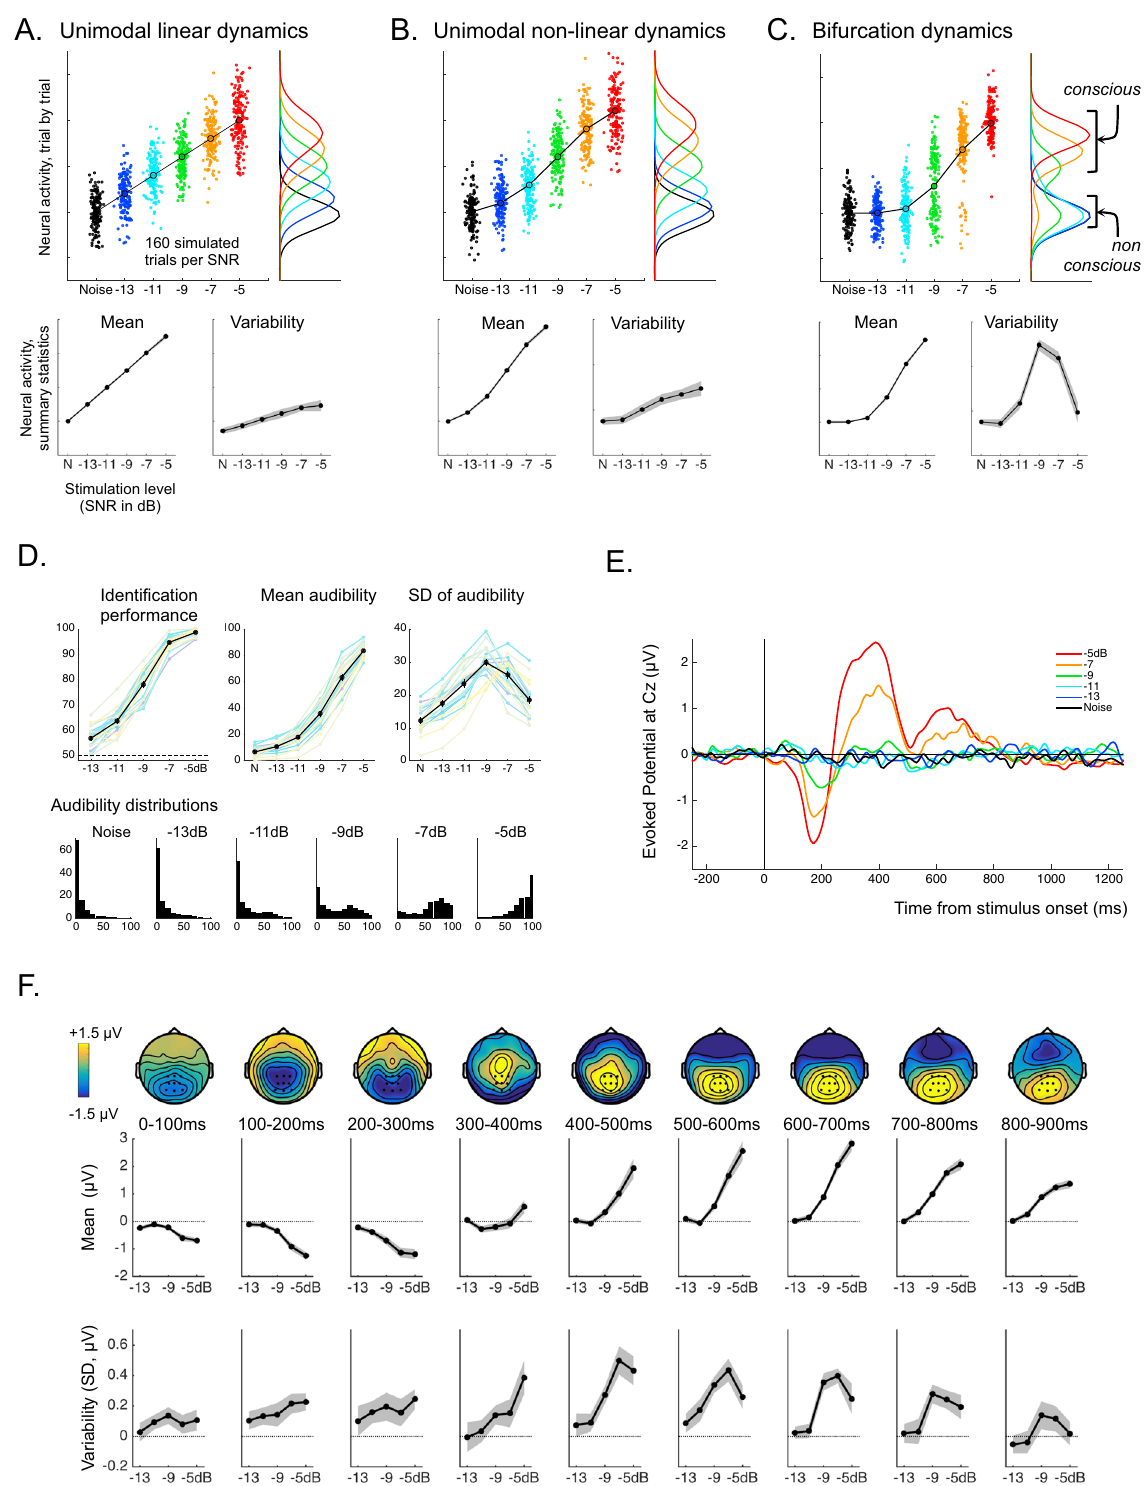
yields a mixture of high- and low-activity trials, this produces a burst in inter-trial variability. For stimulation well above or well below threshold, in contrast, activity is more homogenous across trials, leading to lower inter-trial variability. This produces a highly speci fi c non-monotonous pro fi le in the variability response function for the last model, when variability is plotted as a function of stimulation strength (Fig. 1C).